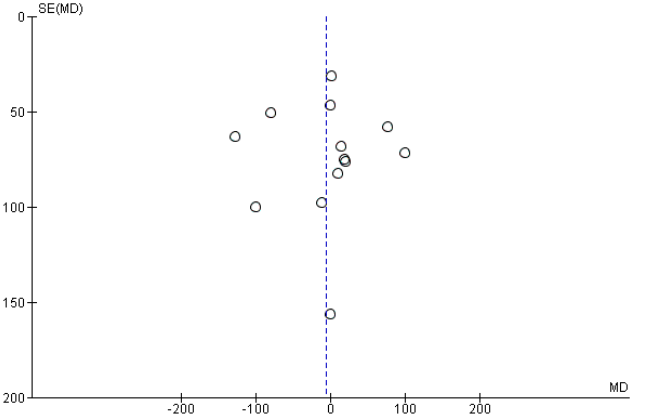
Figure 7. Funnel plot of studies evaluating the administration of probiotic and birth weight.